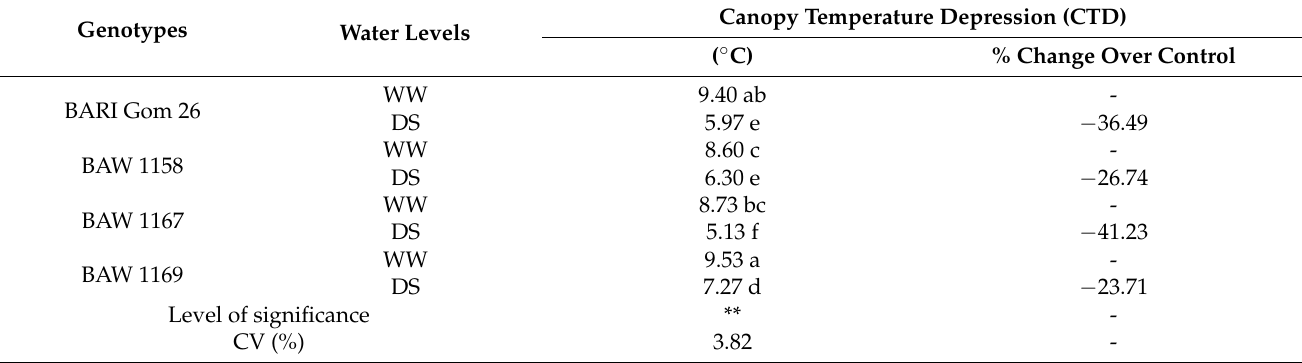
Table 8. Effect of DS on the CTD of different wheat genotypes at 16